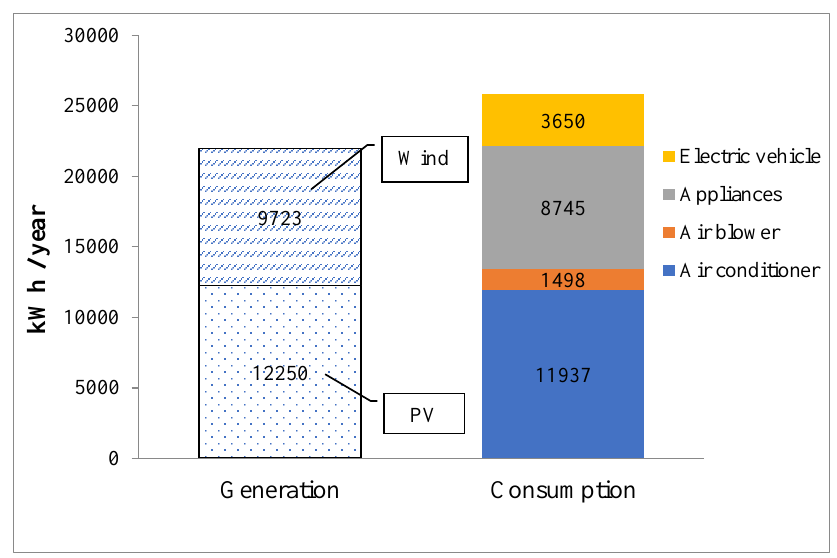
Figure 3. The annual electricity generation and consumption of the building energy system.